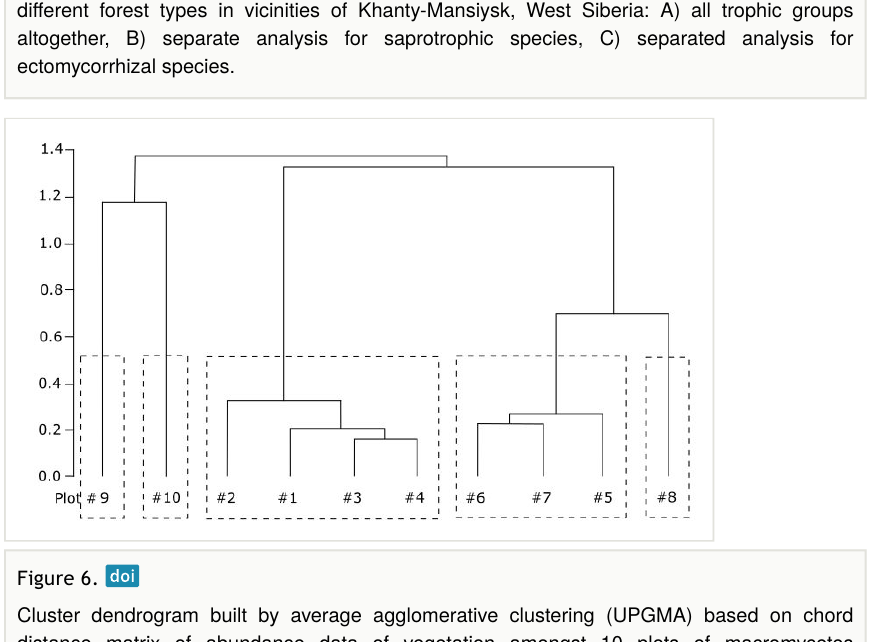
saprotrophic and ectomycorrhizal species (Fig. 5: B, C). The dendrogram of saprotrophic species was close to the general dendrogram described above except for the position of plot 9 (bogged site) which was united in a common cluster with secondary plots. In the